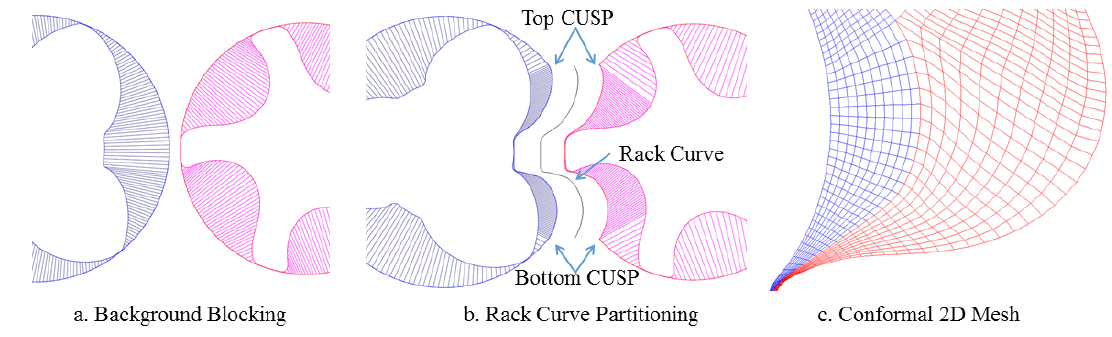
Figure 4. Background blocking used in SCORG for differential mesh.